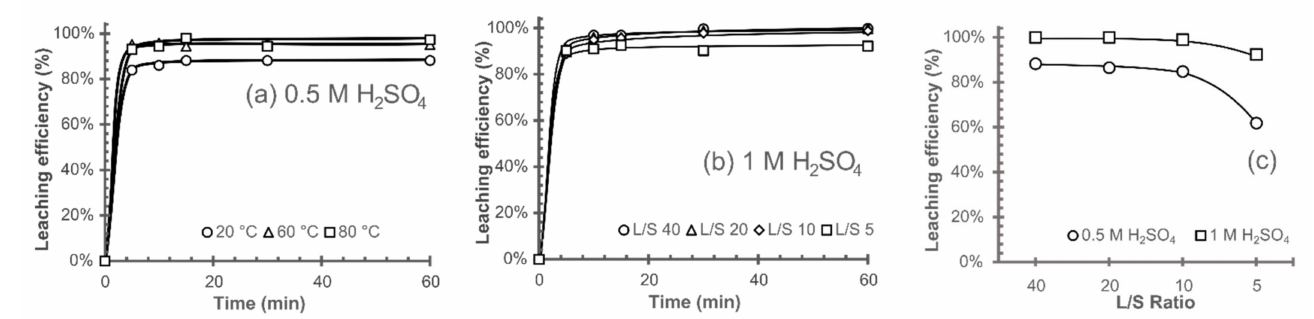
Figure 8. CAF dust leaching efficiency in ( a ) 0.5 M H 2 SO 4 and ( b ) 1 M H 2 SO 4 over time at liquid to solid ratio of 40, 20, 10 and 5 and ( c ) dust leaching efficiency in 60th minute as function of solid to liquid ratio.